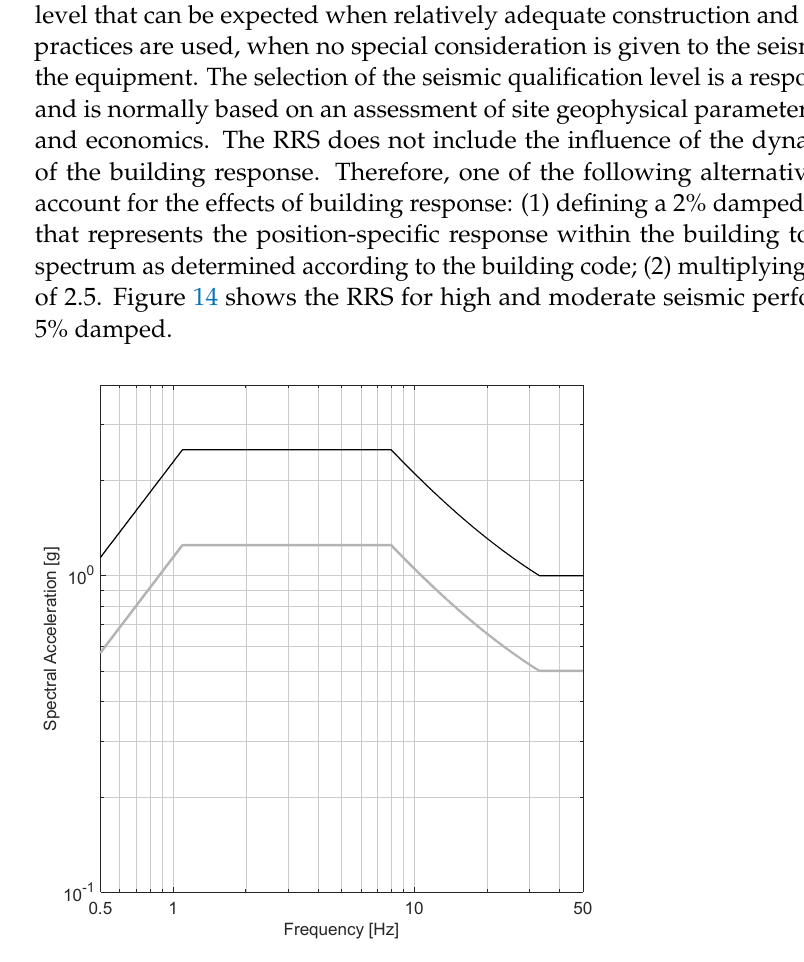
Figure 14. Response spectrum required according to IEEE 693 for high (black) and moderate (grey) seismic performance levels, 5%